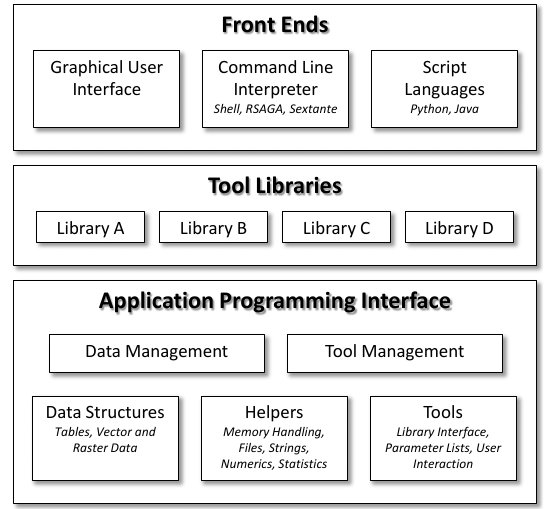
Figure 5. System